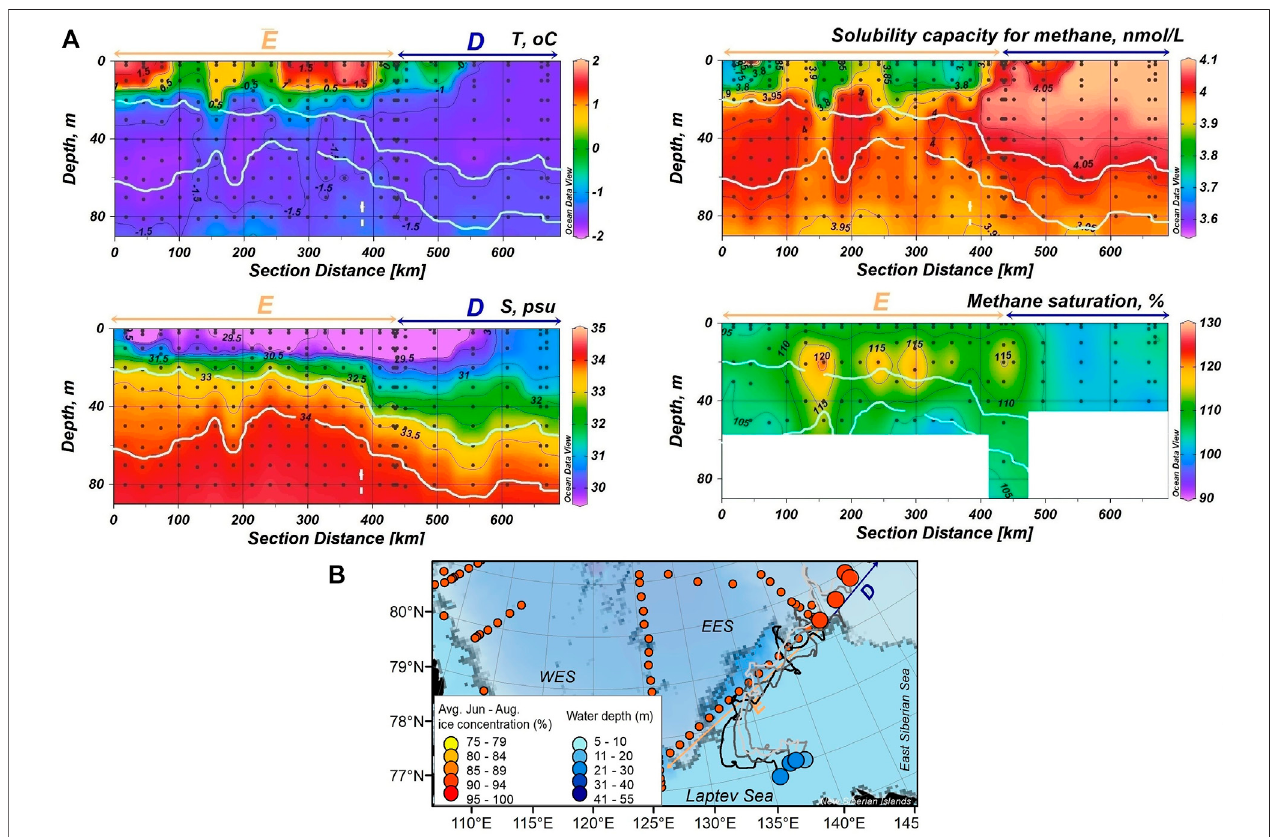
FIGURE6|(A) Pro fi lesoftemperature,salinity,CH 4 solubilitycapacity(SC)andsaturationalongsectionsEandD(fromwesttoeast).LightbluelinesshowtheCHL depths. (B) Backward trajectories of sampled sea ice obtained from IceTrack. The color of the start nodes provides the June-August ice concentration, averaged along the individual track lines. The color of the end notes provide the corresponding water depths at the formation site.